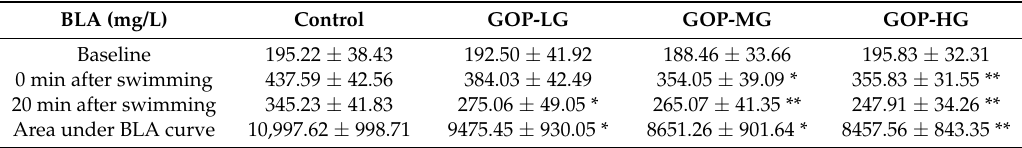
Table 3. Effects of GOP on the content of BLA at different time points in